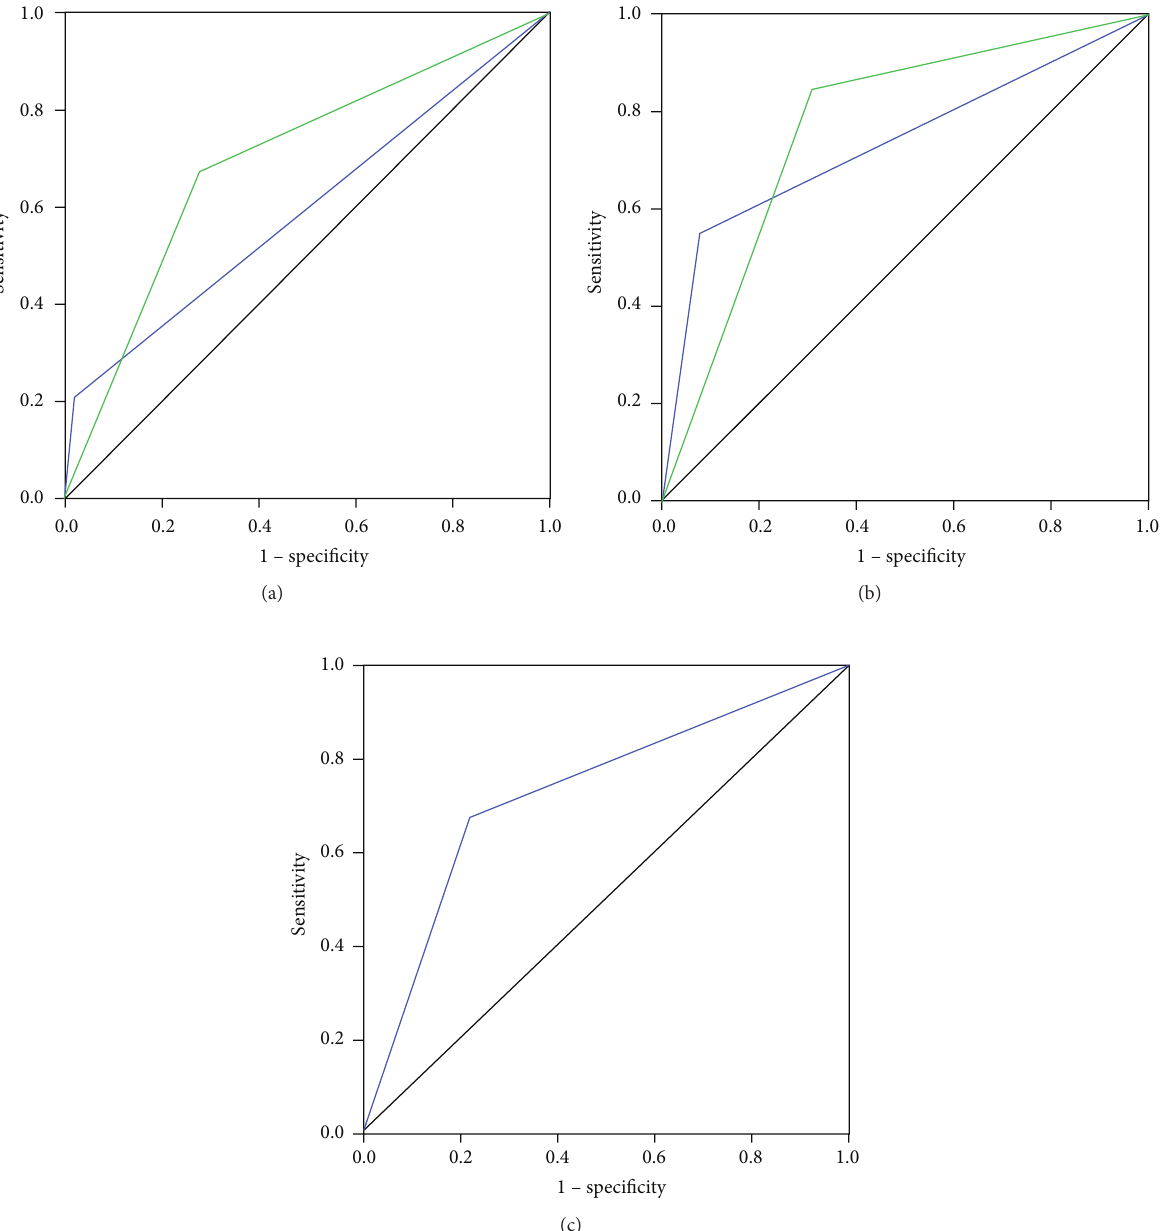
Figure 1: Receiver operating characteristic curves of (a) Hoehn and Yahr at cut-offs of > 3.0 (blue) and > 2.0 (green). (b) Schwab and England ADL scale at cut-offs of < 80% (blue) and < 90% (green). (c) Barthel index score at a cut-off of <